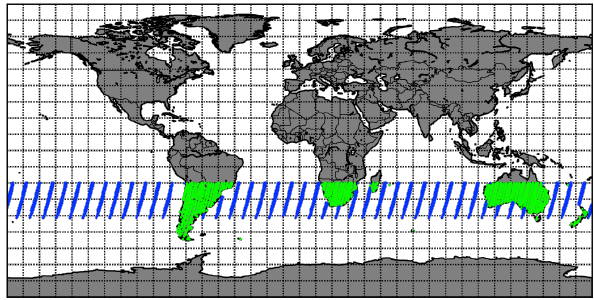
Figure 1. The land and sea data used in the southern hemisphere approximation. This region is 2 Fig. 1. The land and sea data used in the Southern Hemisphere ap- observed to have very low seasonal CO 2 fluctuation relative to the north. 3 proximation. This region is observed to have very low seasonal CO 2 fluctuation relative to the north.